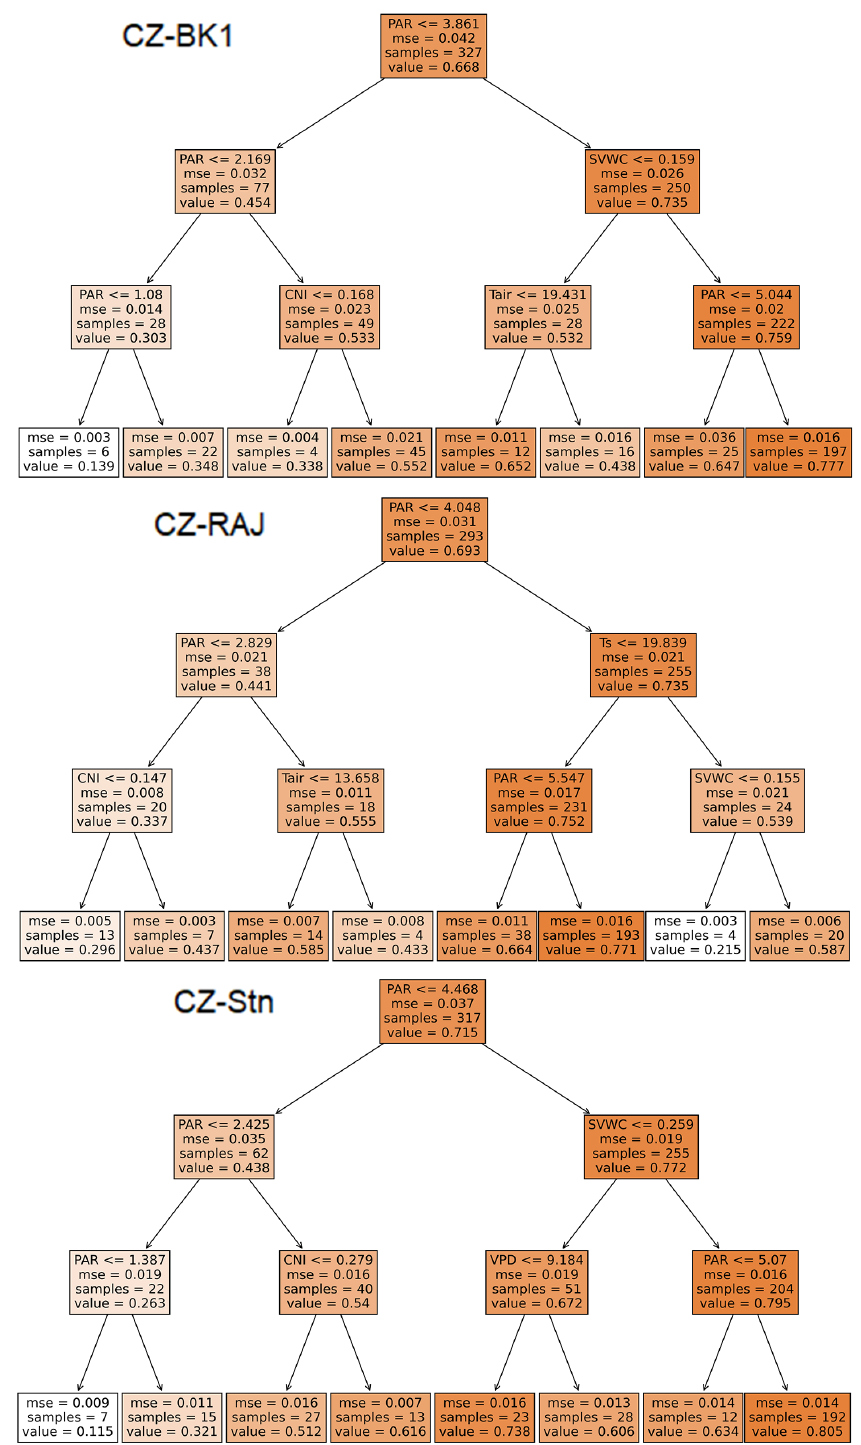
Figure 7. Prediction of normalized GPP (GPP norm ) at the wet spruce forest in Bílý K˘rí˘z (CZ-BK1), the dry spruce forest in Rájec (CZ-RAJ) and the beech forest in Štítná (CZ-Stn) in a form of a decision tree using random forest analyses. The mean square error (mse) indicates the closeness of the predicted GPP norm to the estimated GPP norm . The values are daily GPP norm values. Light colored and white areas represent regions of low GPP norm , and areas with deep color represent regions of high GPP norm . CNI: clearness index; PAR: photosynthetic available radiation; T air : air temperature; T s : soil temperature; SVWC: the soil volumetric water content; and VPD: vapour pressure